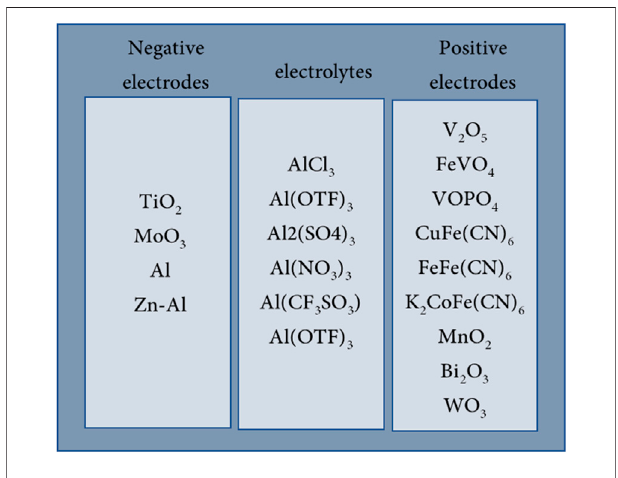
FIGURE 2 | Key materials studied in aqueous Al-ion batteries.